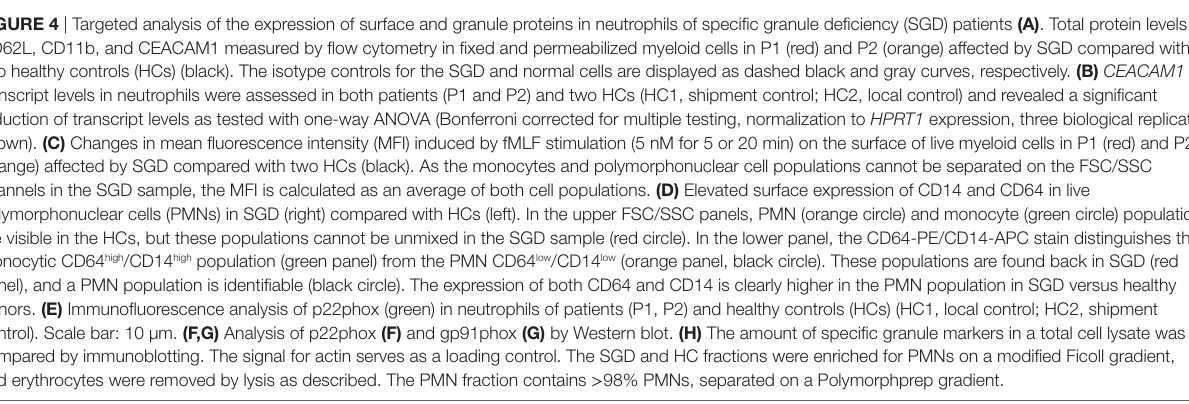
FigUre 4 | Targeted analysis of the expression of surface and granule proteins in neutrophils of specific granule deficiency (SGD) patients (a) . Total protein levels of CD62L, CD11b, and CEACAM1 measured by flow cytometry in fixed and permeabilized myeloid cells in P1 (red) and P2 (orange) affected by SGD compared with two healthy controls (HCs) (black). The isotype controls for the SGD and normal cells are displayed as dashed black and gray curves, respectively. (B) CEACAM1 transcript levels in neutrophils were assessed in both patients (P1 and P2) and two HCs (HC1, shipment control; HC2, local control) and revealed a significant reduction of transcript levels as tested with one-way ANOVA (Bonferroni corrected for multiple testing, normalization to HPRT1 expression, three biological replicates shown). (c) Changes in mean fluorescence intensity (MFI) induced by fMLF stimulation (5 nM for 5 or 20 min) on the surface of live myeloid cells in P1 (red) and P2 (orange) affected by SGD compared with two HCs (black). As the monocytes and polymorphonuclear cell populations cannot be separated on the FSC/SSC channels in the SGD sample, the MFI is calculated as an average of both cell populations. (D) Elevated surface expression of CD14 and CD64 in live polymorphonuclear cells (PMNs) in SGD (right) compared with HCs (left). In the upper FSC/SSC panels, PMN (orange circle) and monocyte (green circle) populations are visible in the HCs, but these populations cannot be unmixed in the SGD sample (red circle). In the lower panel, the CD64-PE/CD14-APC stain distinguishes the monocytic CD64 high /CD14 high population (green panel) from the PMN CD64 low /CD14 low (orange panel, black circle). These populations are found back in SGD (red panel), and a PMN population is identifiable (black circle). The expression of both CD64 and CD14 is clearly higher in the PMN population in SGD versus healthy donors. (e) Immunofluorescence analysis of p22phox (green) in neutrophils of patients (P1, P2) and healthy controls (HCs) (HC1, local control; HC2, shipment control). Scale bar: 10 µm. (F,g) Analysis of p22phox (F) and gp91phox (g) by Western blot. (h) The amount of specific granule markers in a total cell lysate was compared by immunoblotting. The signal for actin serves as a loading control. The SGD and HC fractions were enriched for PMNs on a modified Ficoll gradient, and erythrocytes were removed by lysis as described. The PMN fraction contains > 98% PMNs, separated on a Polymorphprep